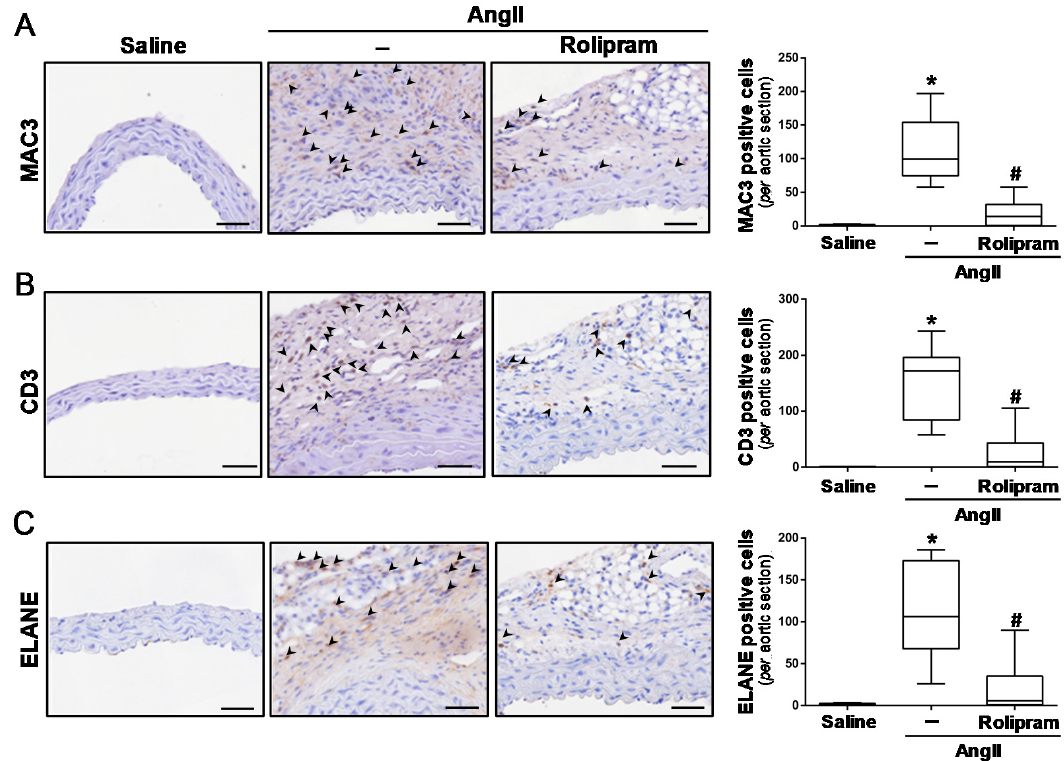
Figure 4. Inflammatory cell infiltration in the abdominal aorta from AngII-infused ApoE − / − mice is attenuated by rolipram. ApoE − / − mice were infused with saline solution or AngII (1000 ng/kg/min) for 28 days. The mice challenged with AngII were treated or not with rolipram (3 mg/kg/day). ( A – C ) Representative images corresponding to macrophage (( A ) MAC3), lymphocyte (( B ) CD3) and neutrophil (( C ) neutrophil elastase, ELANE) infiltration, analysed by immunohistochemistry. The arrowheads indicate positive cells (Bars: 50 µ m). The boxplots on the right show the quantification of the positive cells for Mac-3, CD3, and the neutrophil elastase per aortic section. The box extends from the 25th to the 75th percentile, and the median is indicated by a horizontal line. The whiskers represent the maximum and minimum values (saline-infused mice, n = 5; AngII-challenged mice, n = 8; AngII-challenged mice treated with rolipram, n = 6). In ( A – C ), p < 0.05: * vs. saline-infused mice; # vs. AngII-challenged mice.